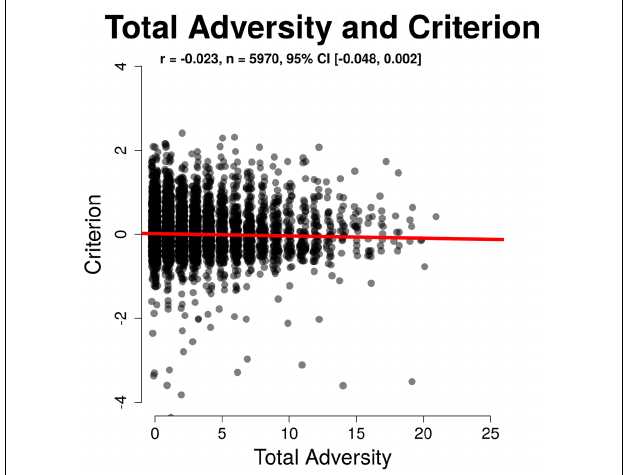
FIGURE 4 | Non-significant relation between total adversity and criterion.